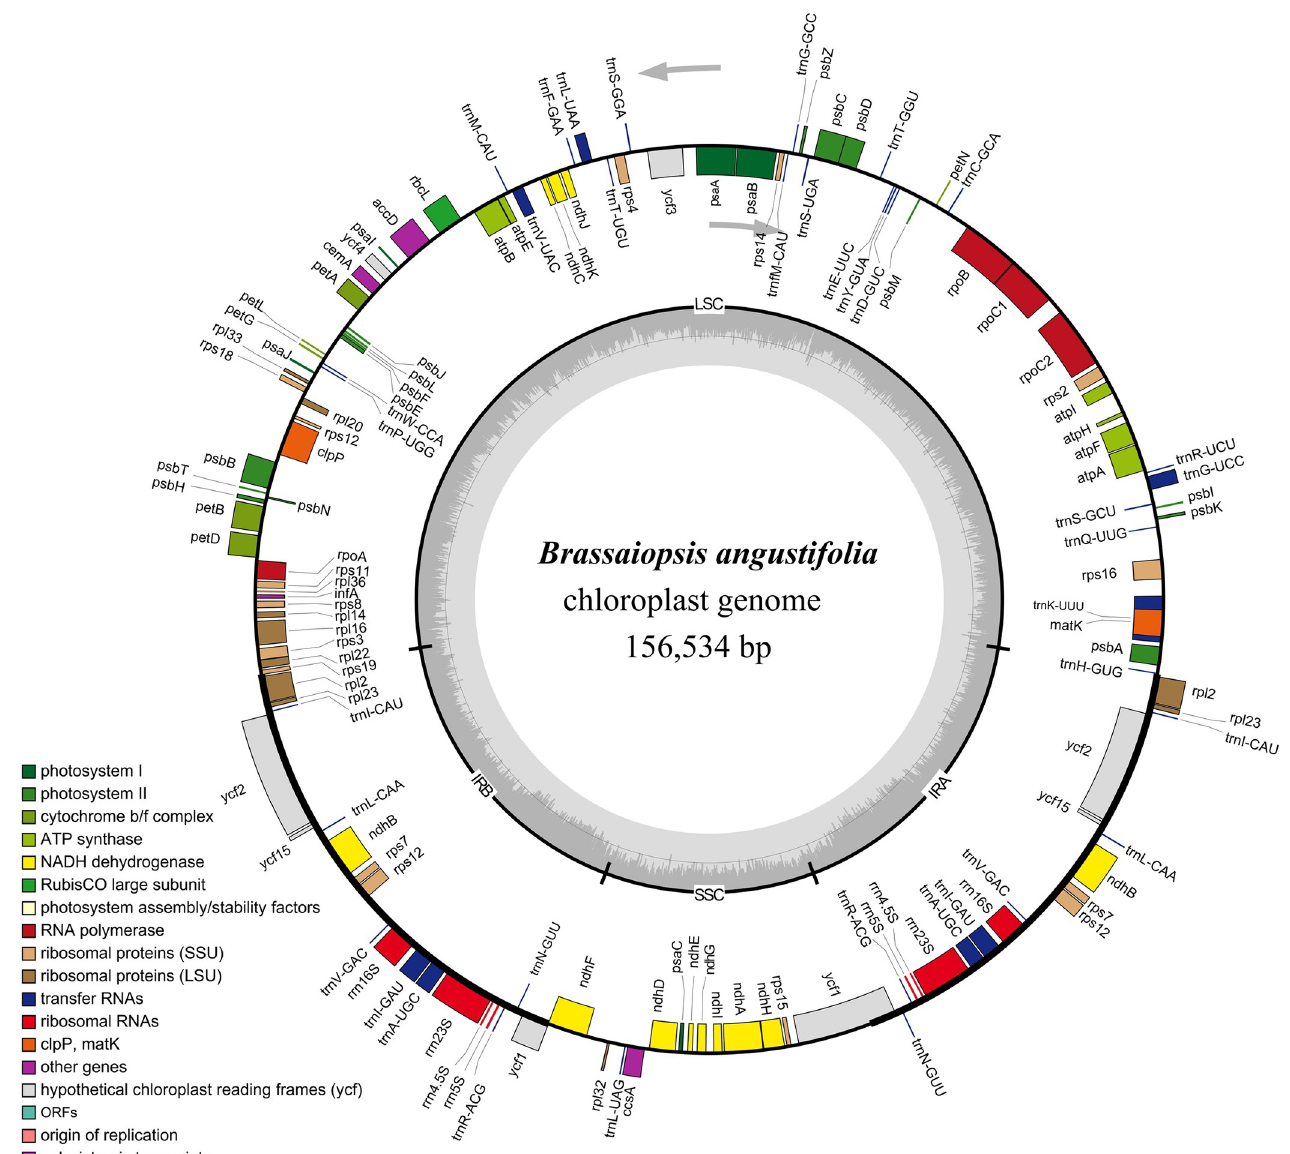
Fig 1. Circular map of chloroplast genome of Brassaiopsis angustifolia with annotated genes. Genes shown inside and outside of the circle are transcribed in clockwise and counterclockwise directions, respectively. Genes belonging to different functional groups are color-coded. The GC and AT content are denoted by the dark gray and light gray colors in the inner circle,